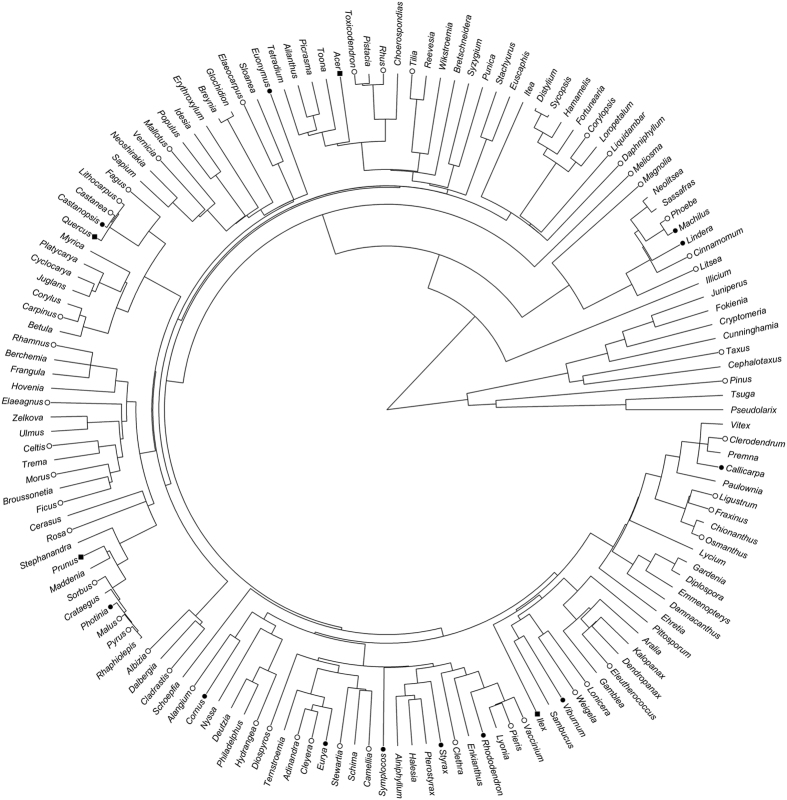
Phylogeny showing the 147 genera and their species richness in the studied plots (for illustrative purposes; analyses are based on a species-level phylogeny, see Materials and Methods).The number of species in each genus is indicated by symbols: tip with no symbol represents 1 species in the genus; open circle is 2–5 species; filled circle is 6–10 species; filled square is >10 species.